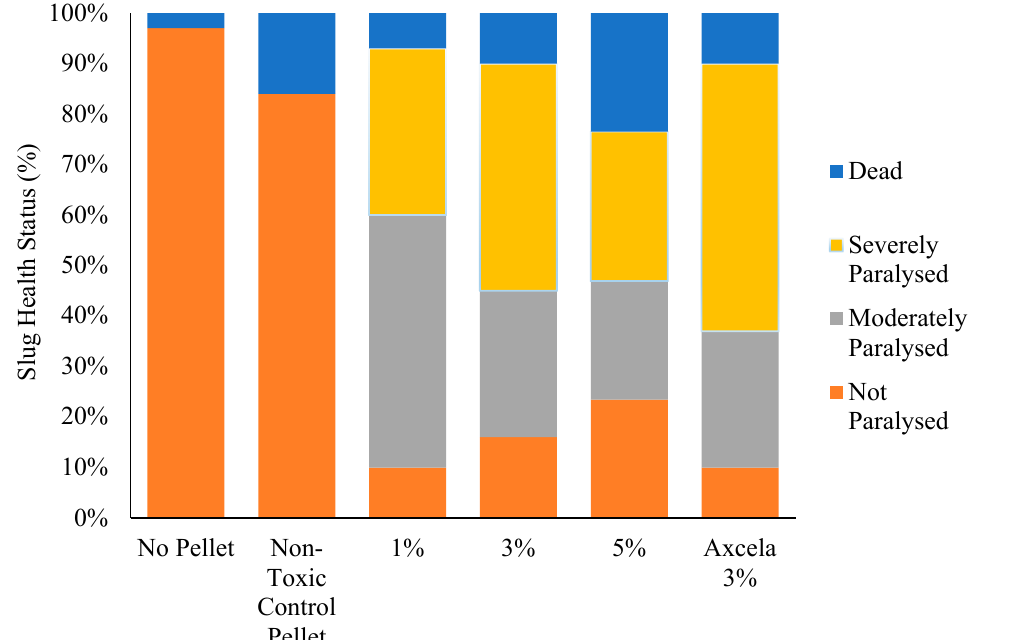
Figure 1. Health status of a population of 30 Deroceras reticulatum after 14 h of exposure to pellets of varying levels of metaldehyde concentration. Each slug population was subject to only one treatment pellet ( n = 30) . The relative mortality of slugs between treatments did not change from 14 h to 72 h (X 2 (16) = 4.918, p > 0.05).